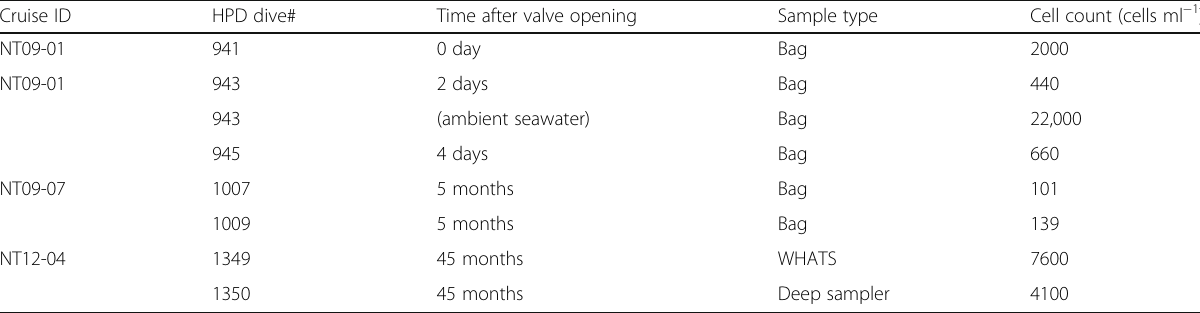
Table 2 Microbial cell density in the CORK fluid and ambient seawater samples